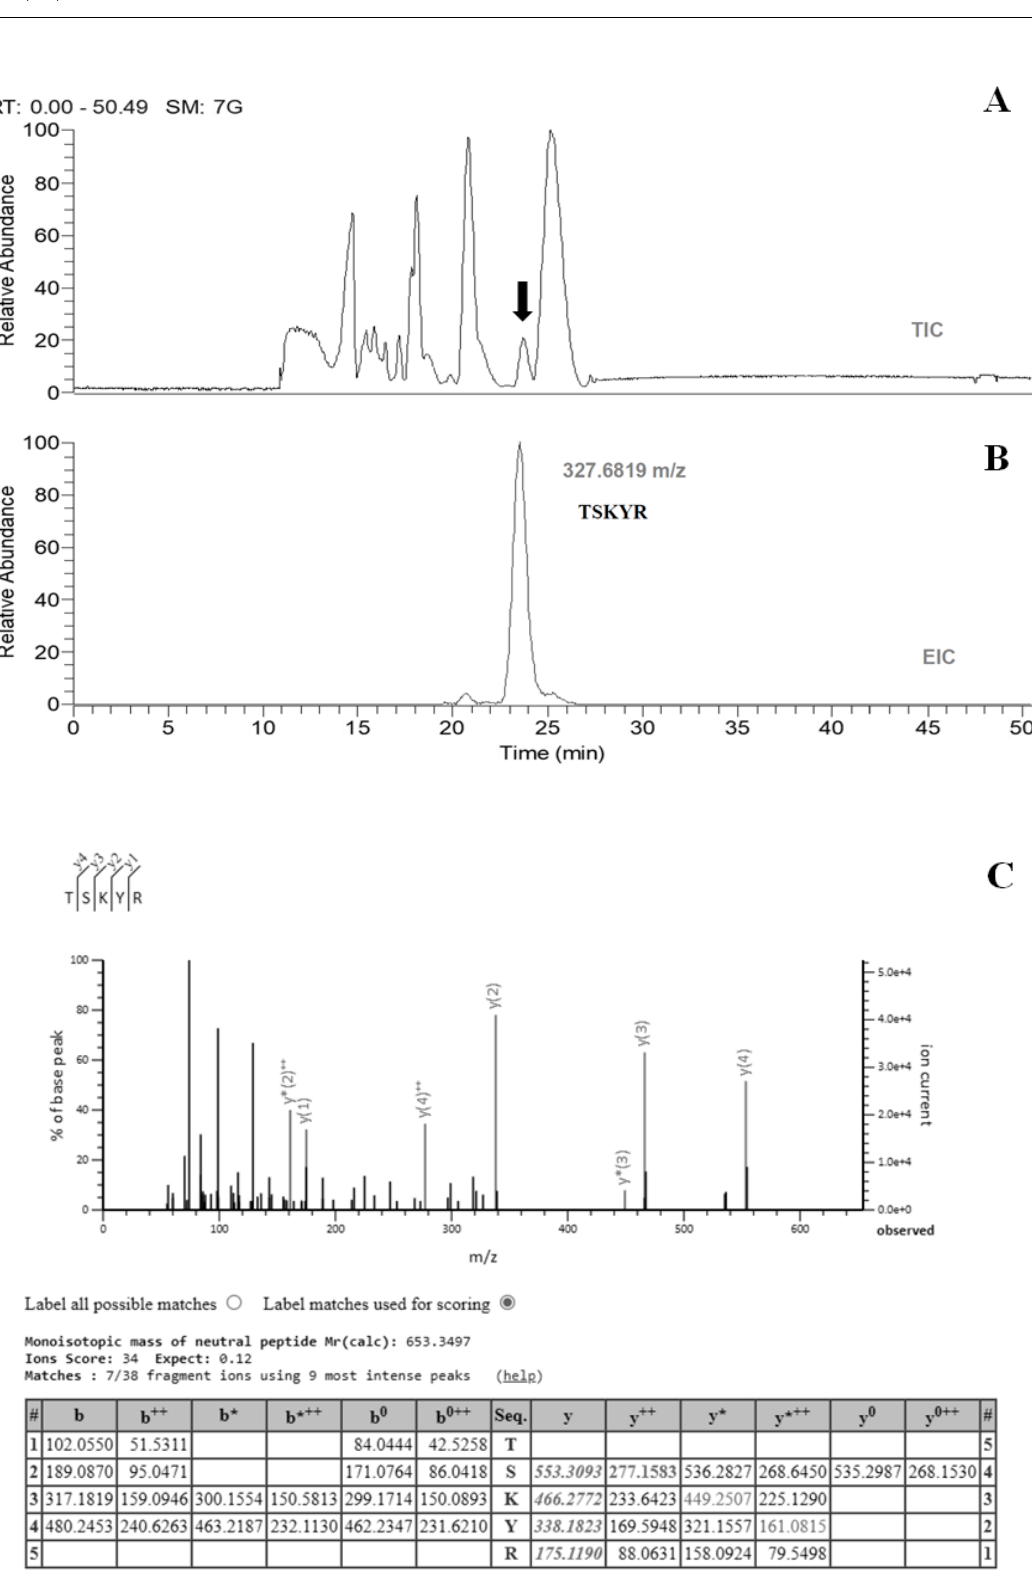
Figure 1. Identification of active peptide from pepsin‑digested samples by LC‑MS. ( A ) Total ion chromatogram (TIC) of test sample, where the vertical arrow indicates the elution peak with the activity of stimulating osteoblast proliferation. ( B ) Extracted chromatogram (EIC) of test sample, the identified peak with a m / z value of 327.6819. The values of observed and calculated molecular weights were 653.3493 and 653.3497, respectively (mass error = − 0.47 ppm). ( C ) Collision‑induced dissociation (CID) spectrum of the active peptide.